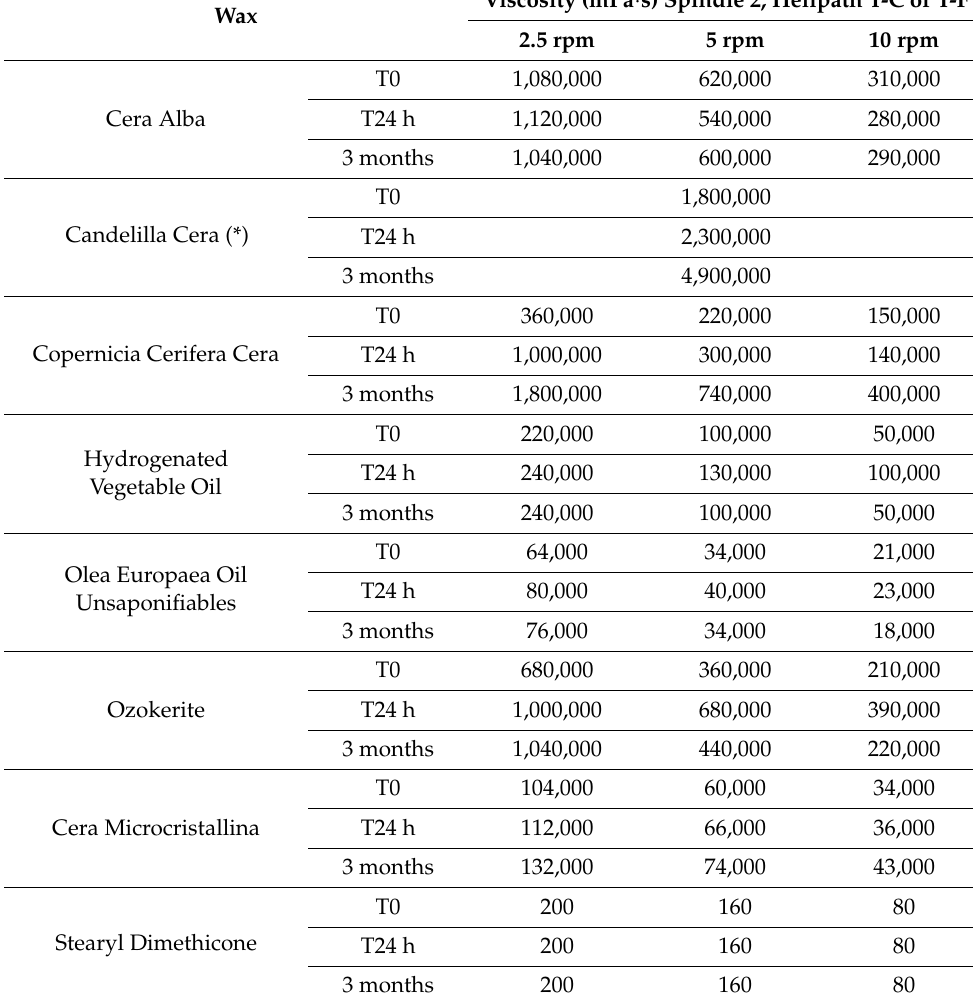
Table 5. Viscosity values of the new oil blended with 25% waxes at T0, T24 h, and after 3